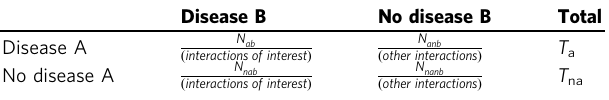
Table 1 Contingency